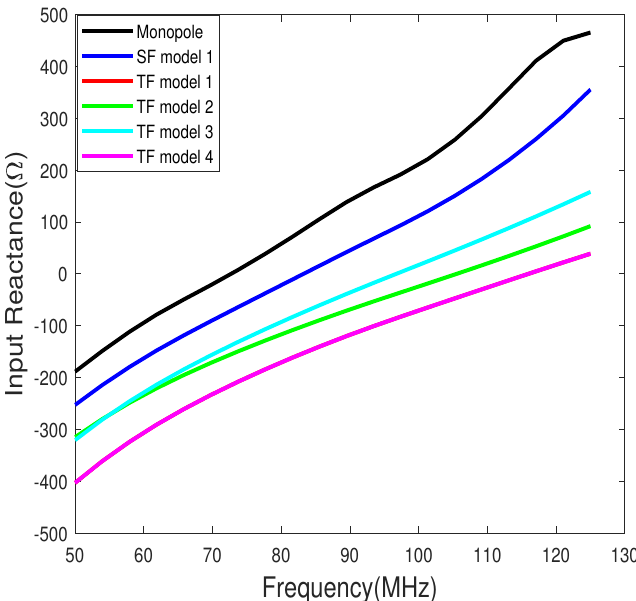
Figure 24. Input reactance of the two-fold antenna models from FEKO.